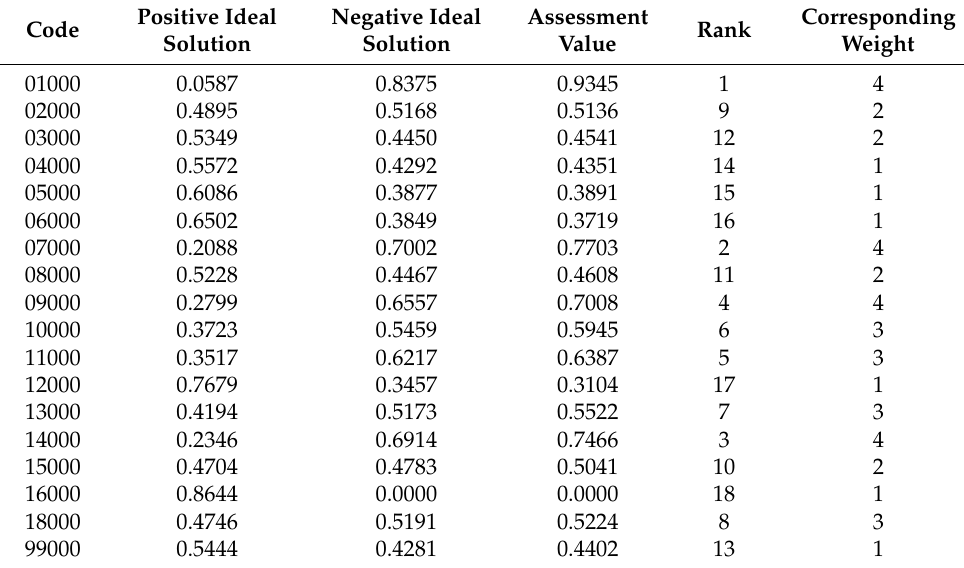
Table 9. Table of TOPSIS analysis